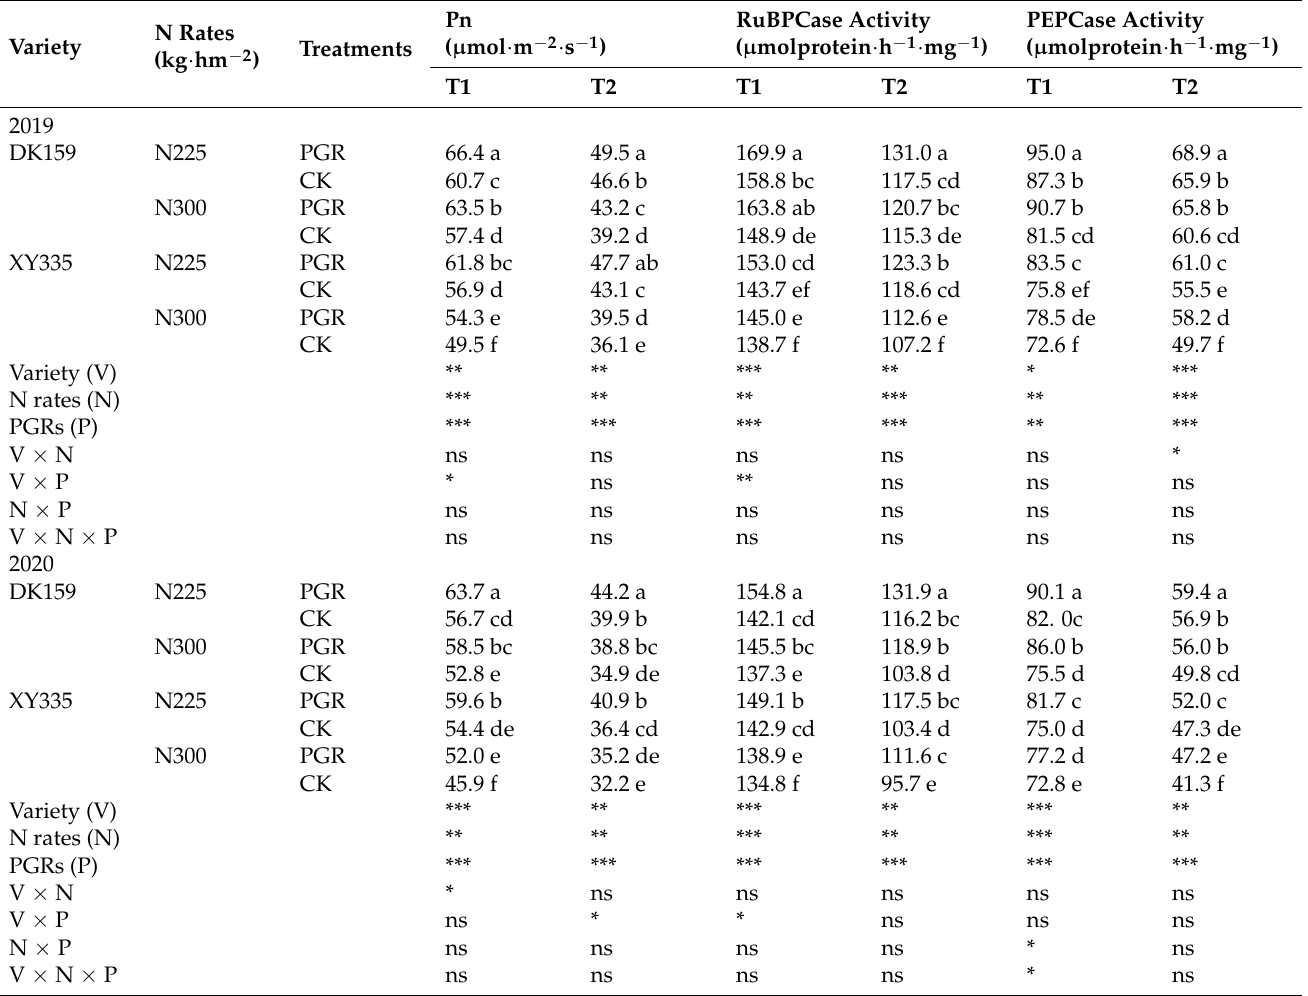
Table 2. Effects of PGRs and nitrogen fertilizer on the photosynthetic characteristics of ear